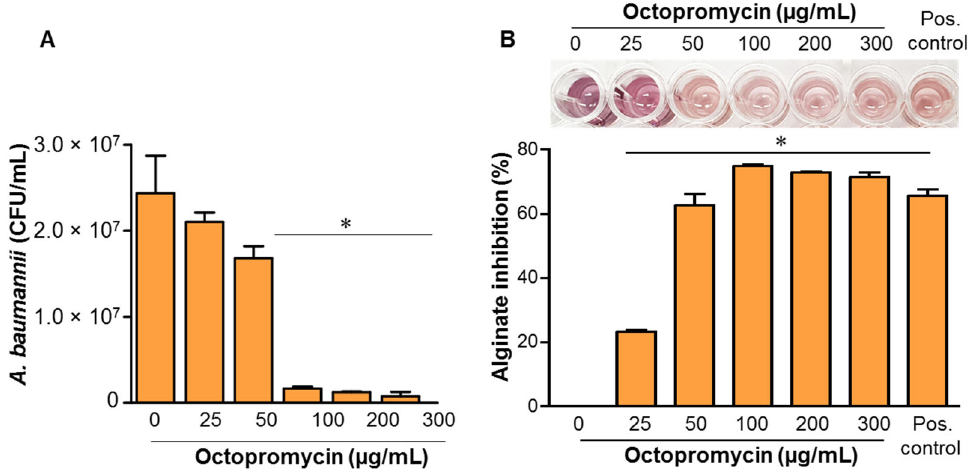
Figure 2. Inhibitory effect of octopromycin on persister cells and alginate production in A. baumannii